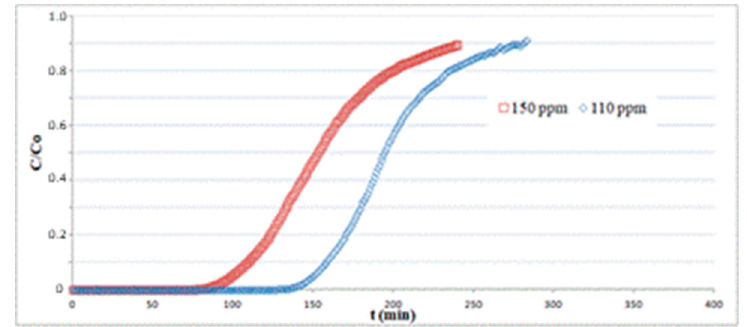
= 25 ◦ 2 S concentrations at T